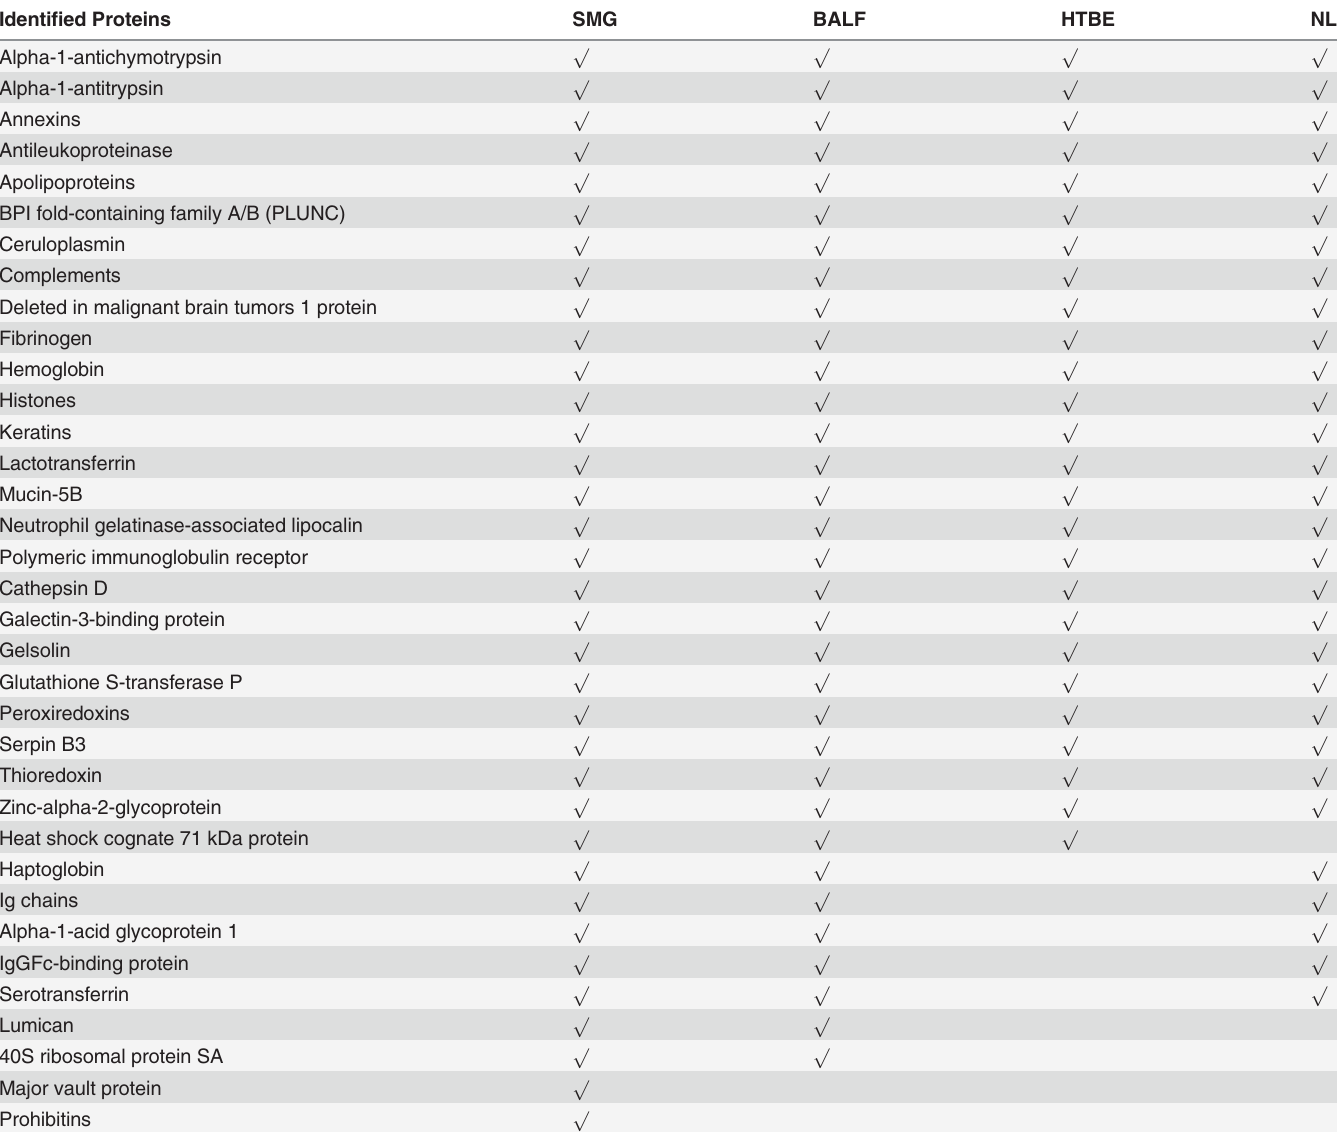
Table 2. A comparative analysis of anti-proteins of 4 airway